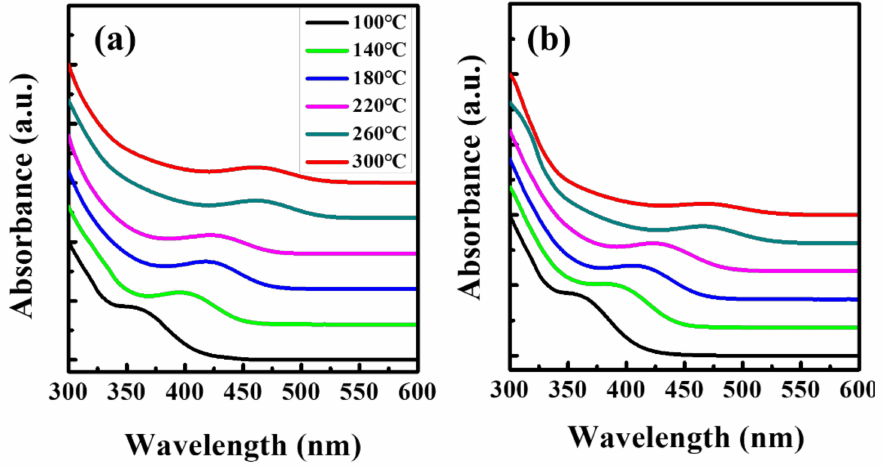
Figure 4. Temporal evolution of the UV–vis absorption spectra of InP / GaP / ZnS QDs prepared with ( a ) oleic acid and ( b ) stearic